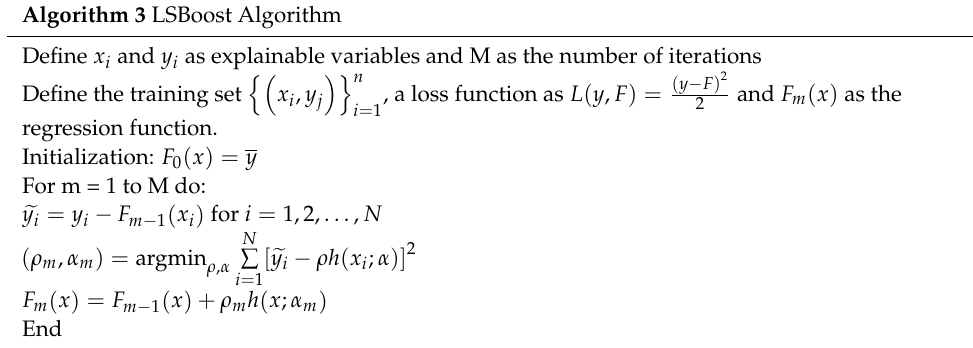
Algorithm 3 LSBoost Algorithm